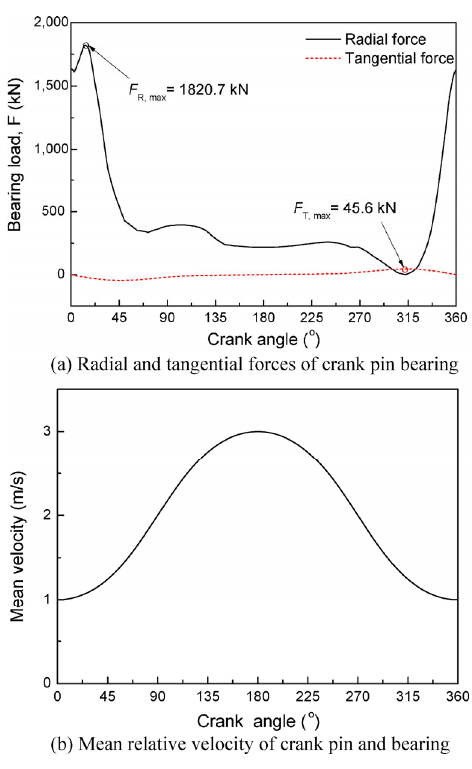
Fig. 6 Internal loads of crank pin bearing and mean relative velocity of crank pin and bearing with crank angle.